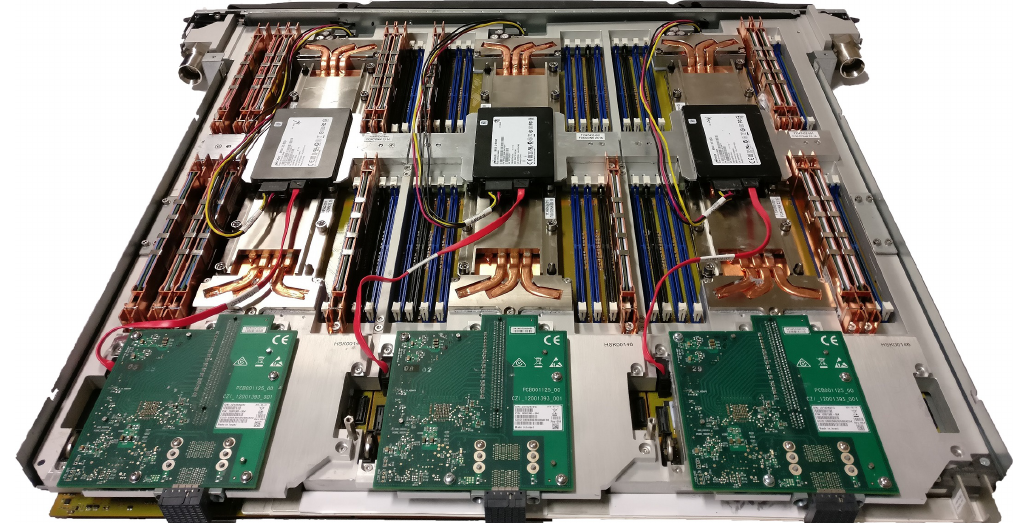
Figure 2: Example of a BullSequana compute blade encompassing three compute nodes. Please note that the shown local storage devices are not built into the JUWELS compute nodes. Copyright: Atos.